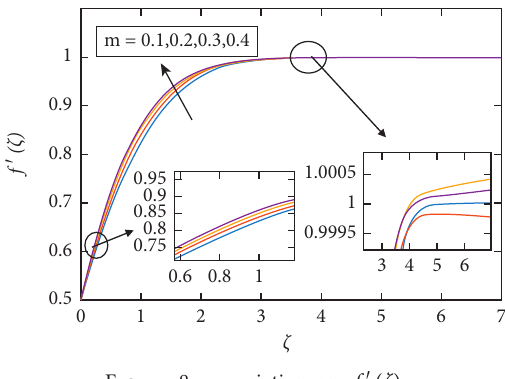
Figure 5: φ variation on θ ( ζ ) . 2